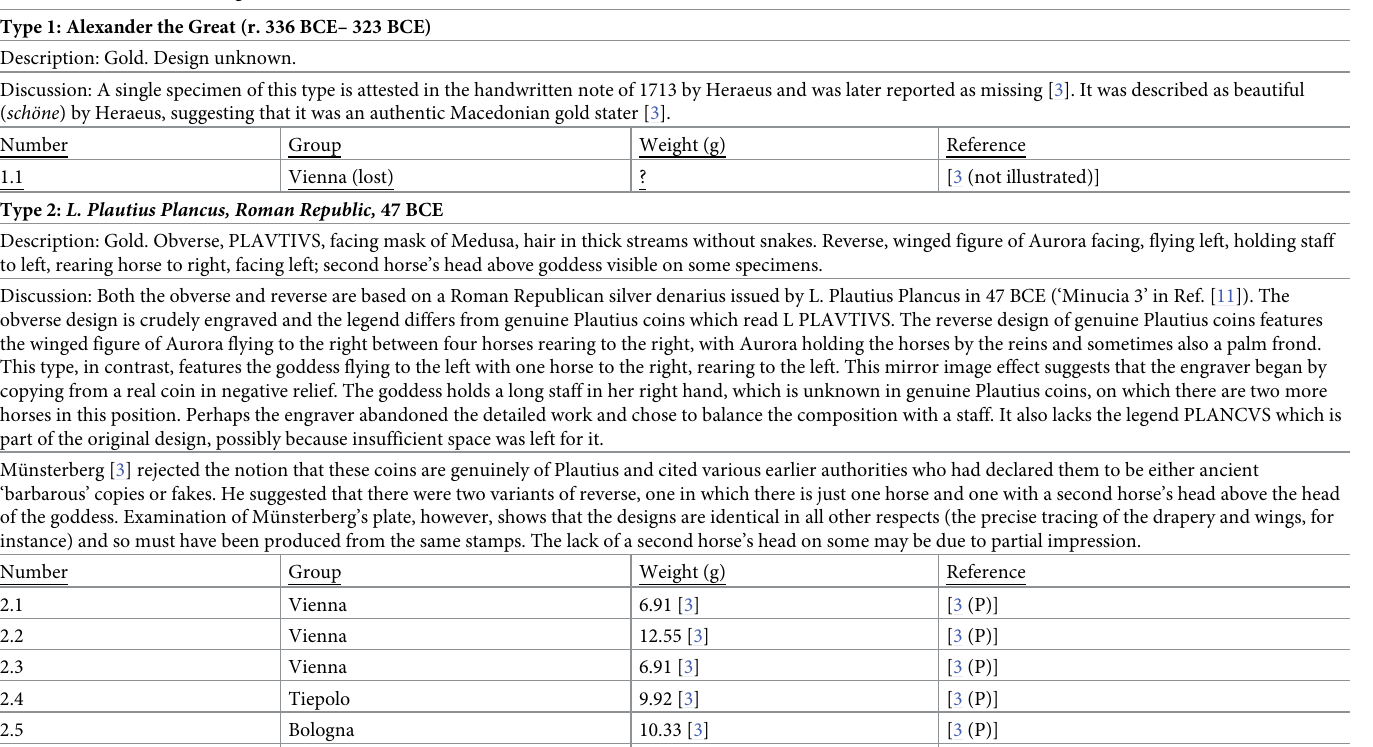
Table 1. List of known coins from the wider assemblage, classified according to type. Note that when more than one weight is given in the literature the most recent is preferred. References are for specimens illustrated by line drawing or photography (‘P’ denotes a photograph) except where no illustration exists when the earliest pub- lished reference to the coin is